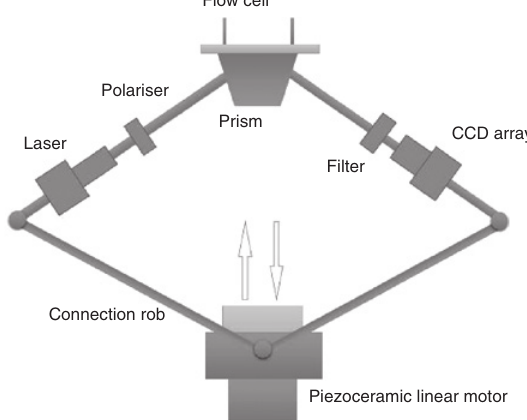
Figure 2: Schematic of a rhombic-shaped angle interrogation SPRi system based on a piezoceramic motor. Reprinted with permission from Ref.